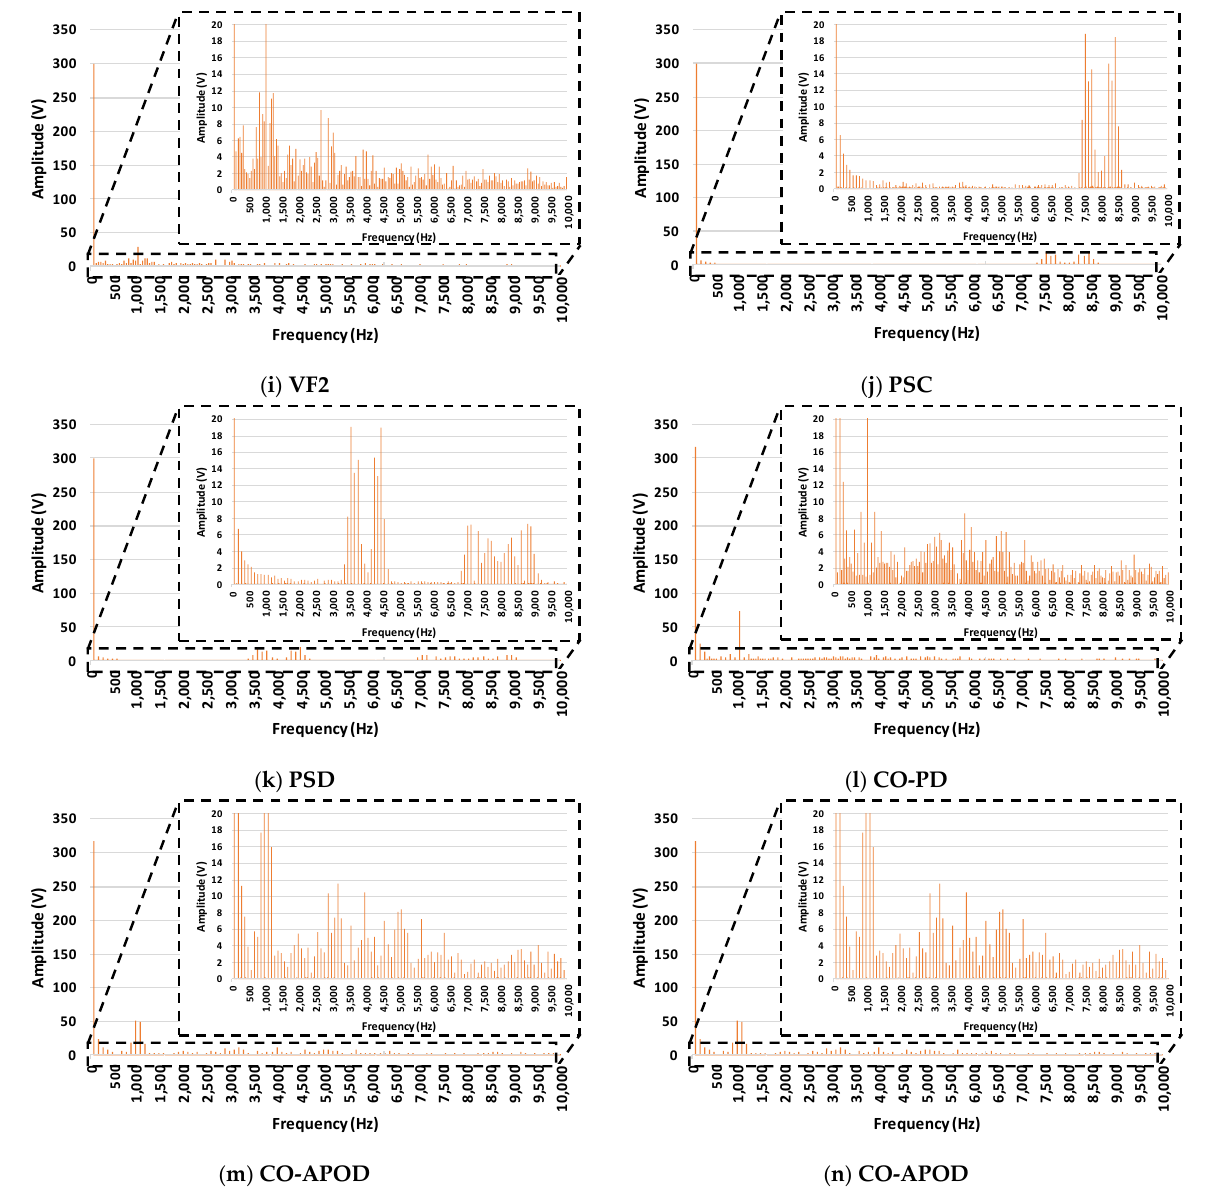
Figure 27. Harmonic spectrum of the v out for different PWM techniques: ( a ) PD, ( b ) Balanced PD, ( c ) POD, ( d ) Balanced POD, ( e ) APOD, ( f ) Balanced APOD, ( g ) CO, ( h ) VF, ( i ) VF2, ( j ) PSC, ( k ) PSD, ( l ) CO-PD, ( m ) CO-POD, and ( n ) CO-APOD.